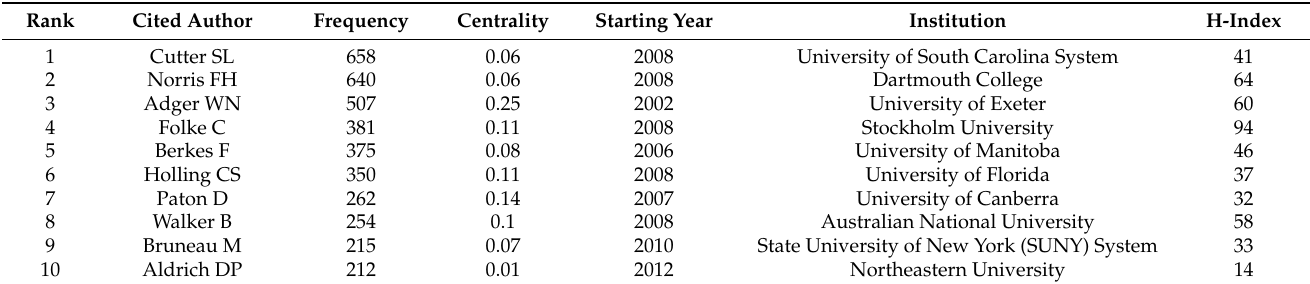
Table 6. Top 10 highly cited authors in community resilience research from 2001 to